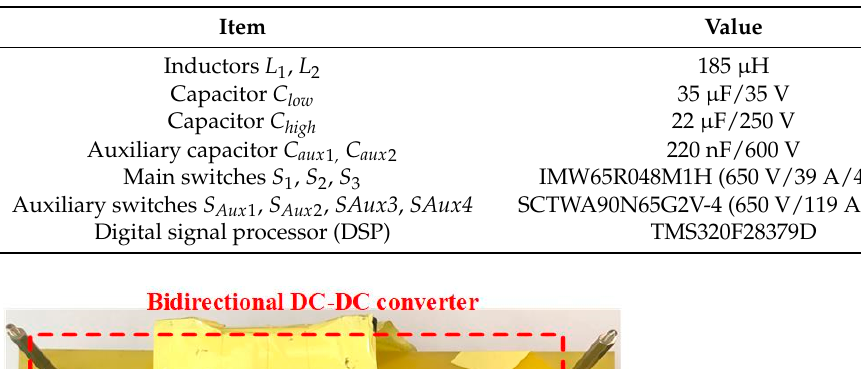
Table 2. Parameters of the experimental system.